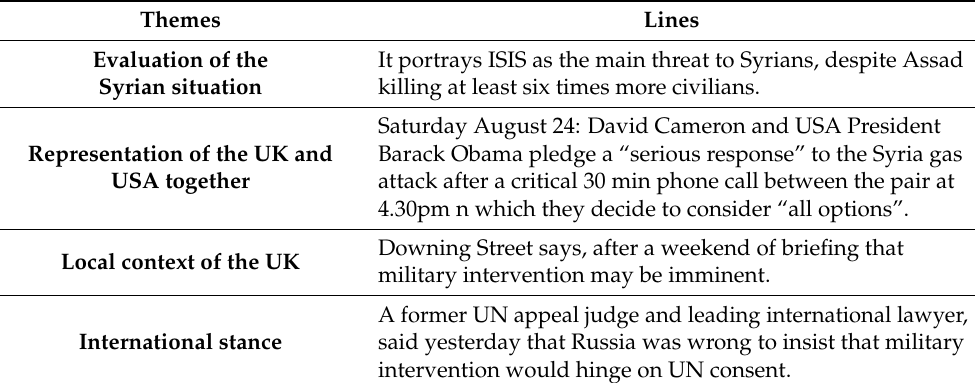
Table 1. Total number of concordance lines and tokens for each theme. Table 2. Sample of thematic analysis from extracted